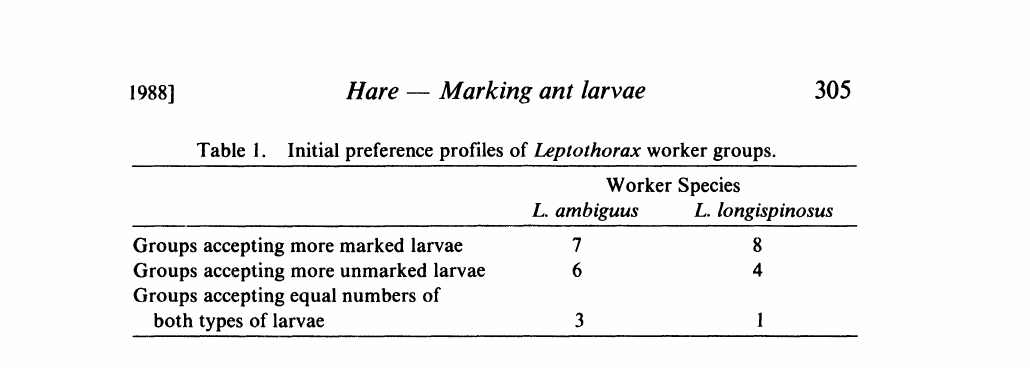
Table 1. Initial preference profiles of Leptothorax worker